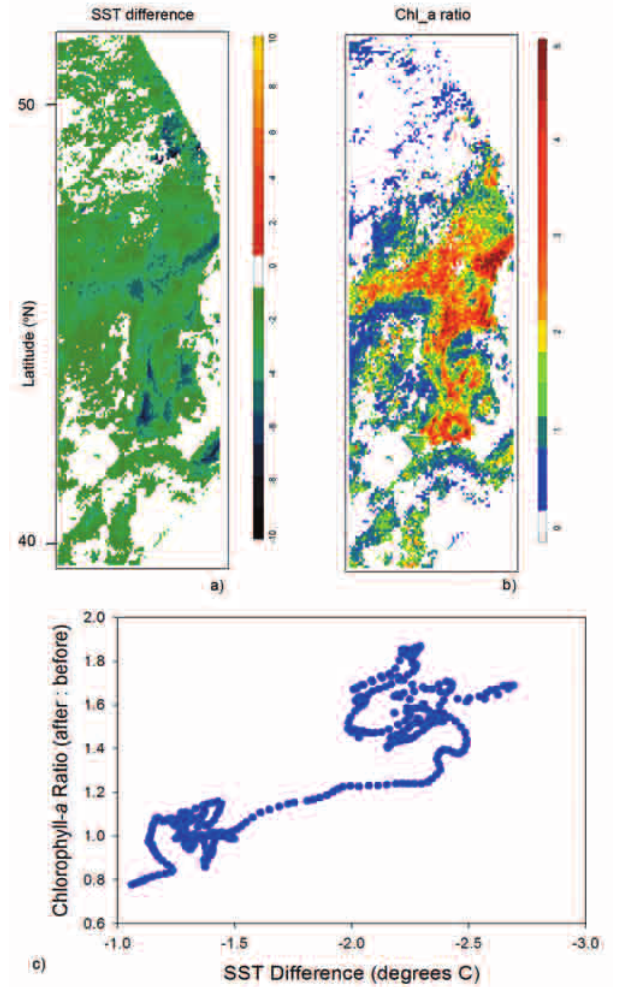
Fig. 13. – Changes in sea surface temperature and chlorophyll-a: a) Difference (after-before) in SST. Green and blue colours show decreased temperatures. b) Ratio (after : before) of chlorophyll-a. Values above 1.0 indicate areas where the phytoplankton biomass increased. c) Scatter plot of concurrent changes in SST (difference) and Chl-a (ratio). The data are extracted from the composite images within a 700 km band (see Fig. 12), and averaged across the storm track. The low (or high) values of change are related with the left (or right) side of the storm